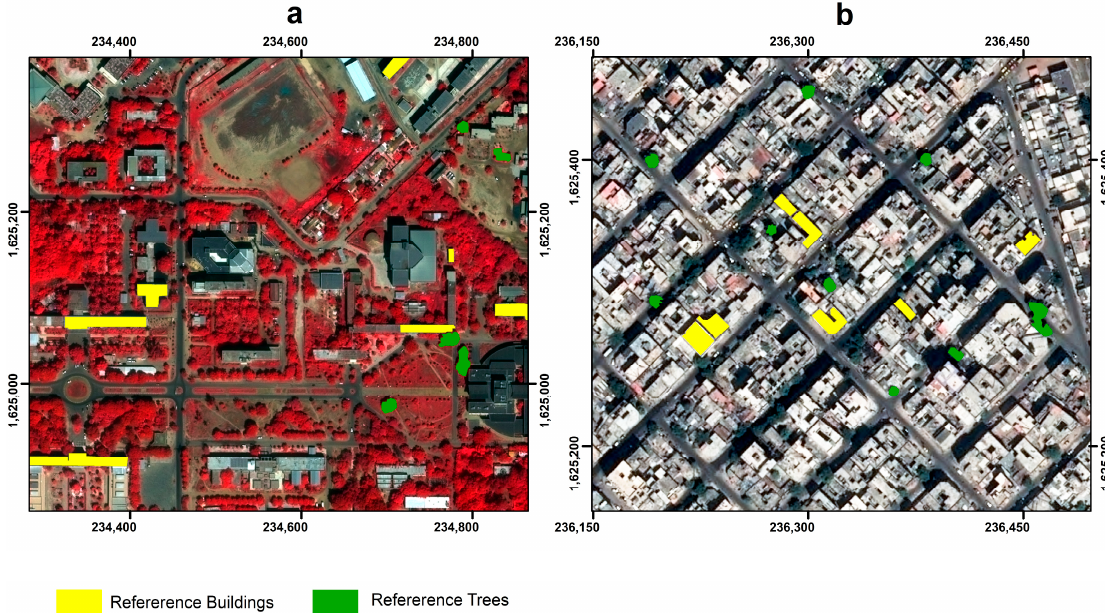
Figure 8. Examples of digitized buildings and trees for the computation of segmentation goodness metrics in ( a ) ROI 1 and ( b ) ROI 2.